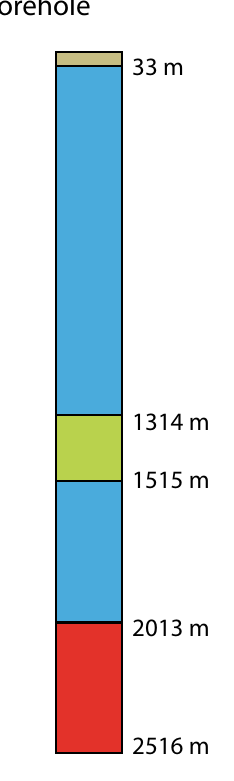
Figure 2. Borehole scheme of the Outokumpu well with simplified lithological units (Kukkonen, 2007).